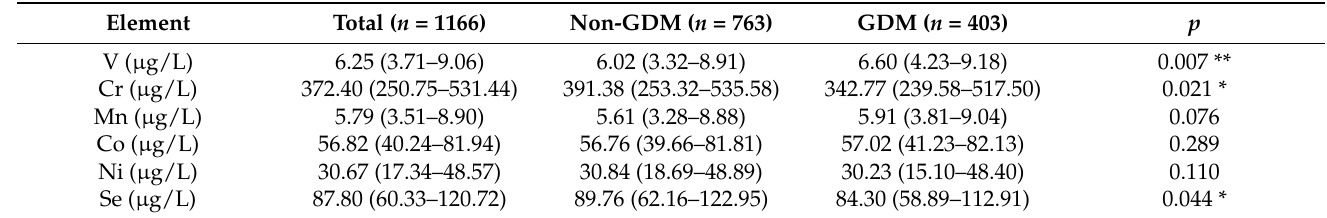
Table 2. Profiling of trace elements in maternal plasma of the case-control